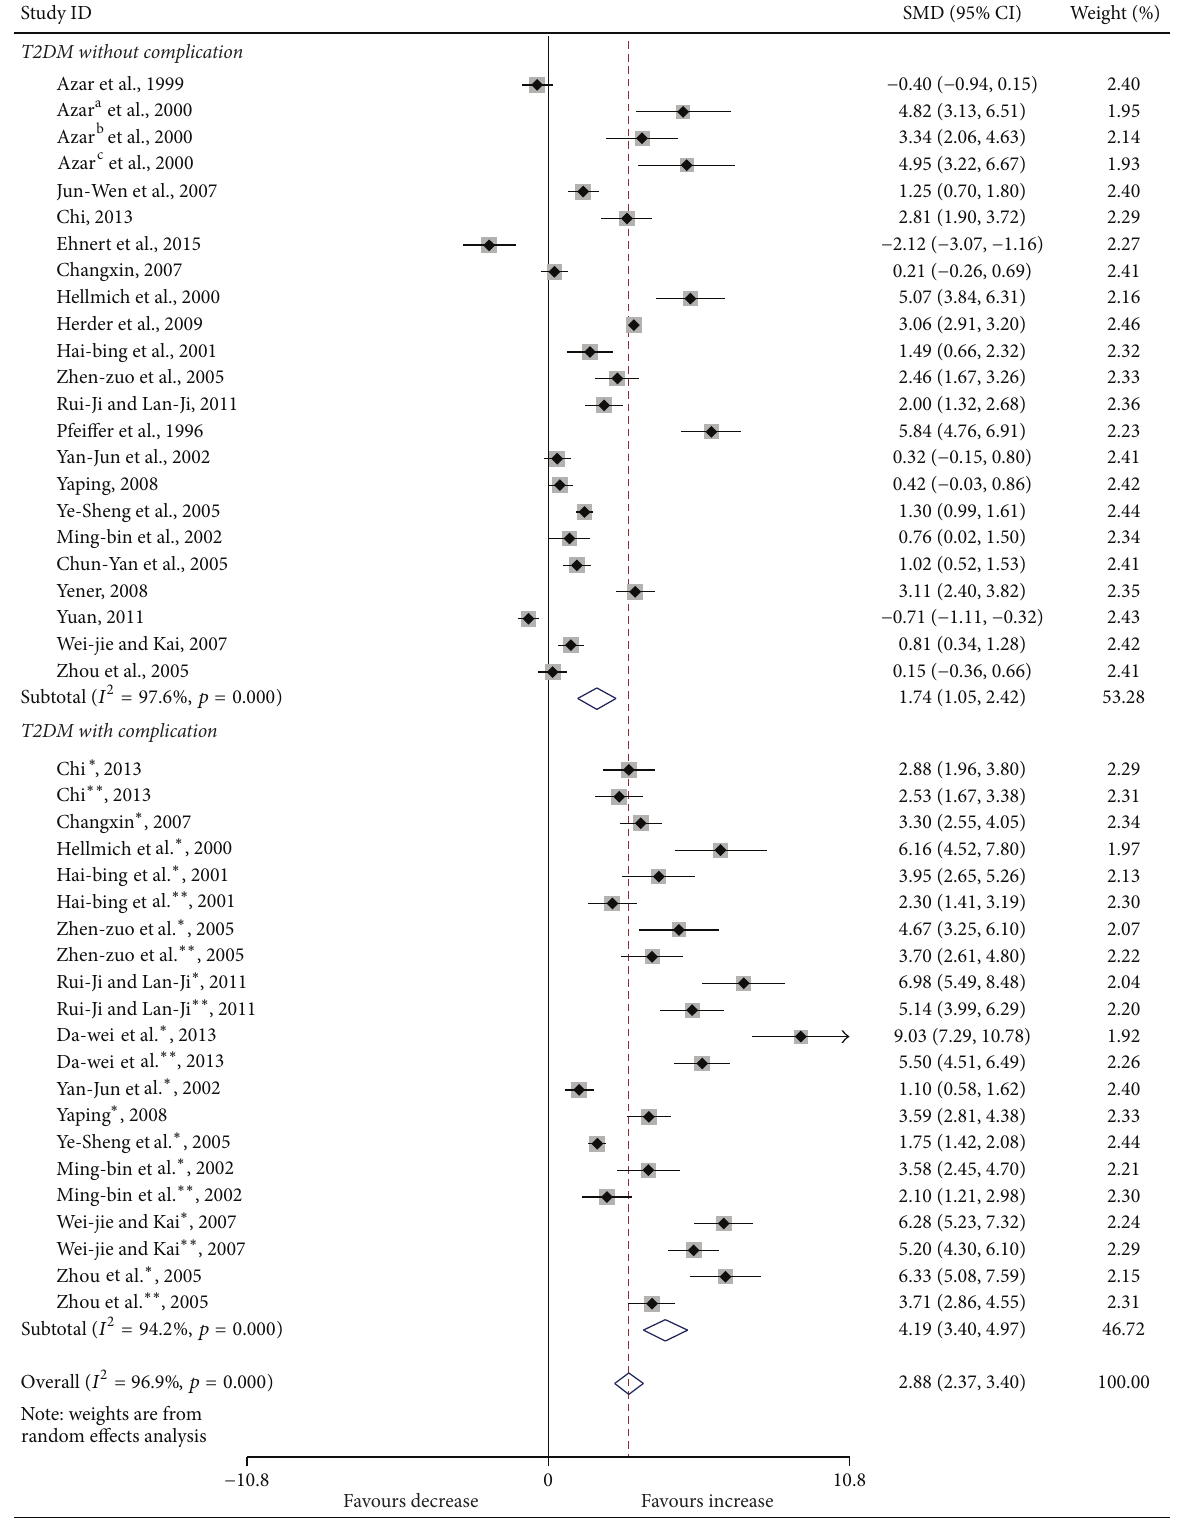
Figure 3: Forest plots for serum TGF- 𝛽 in T2DM patients and controls with random effects model (T2DM without complication, 𝑝 < 0.001 ; T2DM with complication, 𝑝 < 0.001 ; overall, 𝑝 < 0.001 ). ∗ T 2 DM with complication. ∗∗ T 2 DM with different